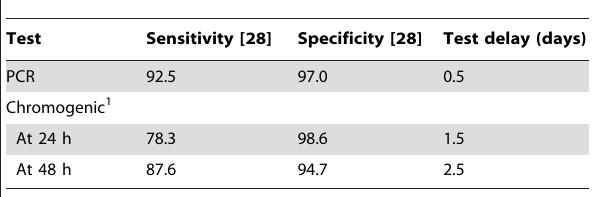
Table 1. Test characteristics. Table 2. Resource use and costs of screening and isolation in US $